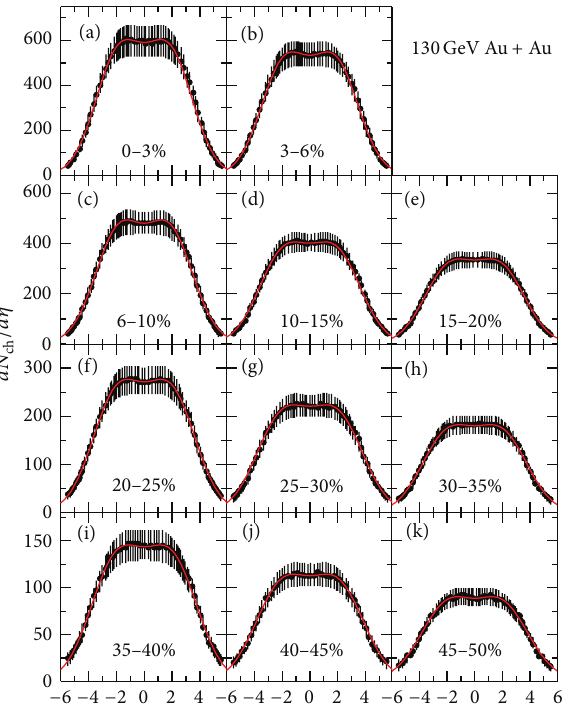
Figure 5: As Figure 1 but showing the results in Cu-Cu collisions at = 22.4 GeV. √𝑠 𝑁𝑁